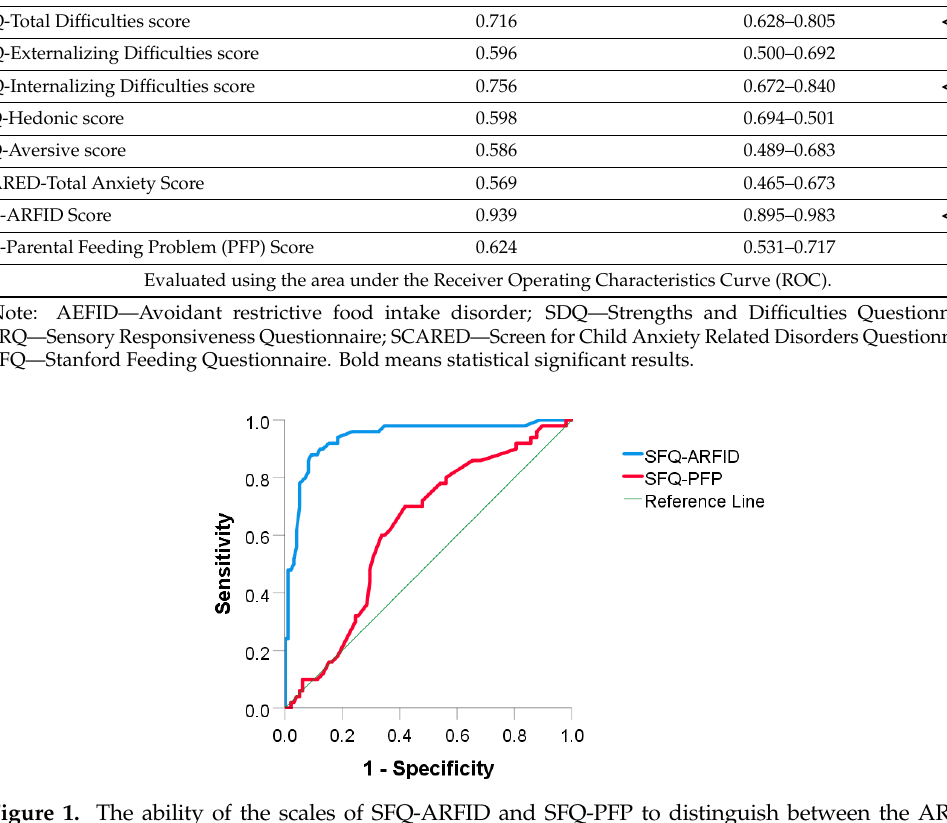
Figure 1. The ability of the scales of SFQ-ARFID and SFQ-PFP to distinguish between the ARFID and control groups using the area under receiver operating characteristics curve (AUROC). Note. ARFID